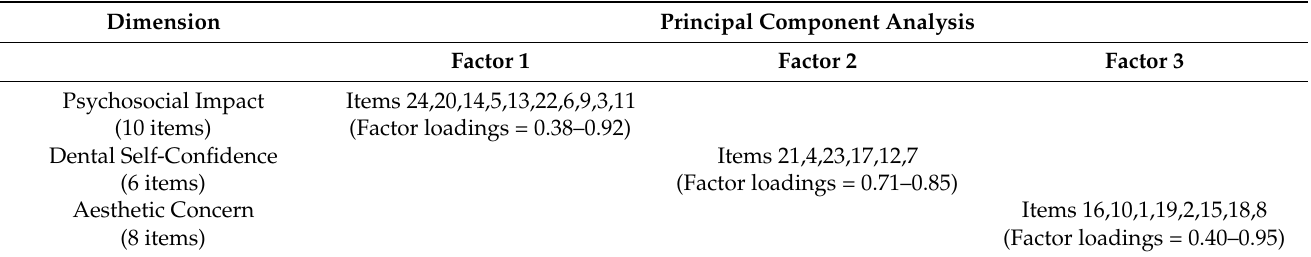
Table 1. Factor loadings of the items of the PIDAQ measure (N =